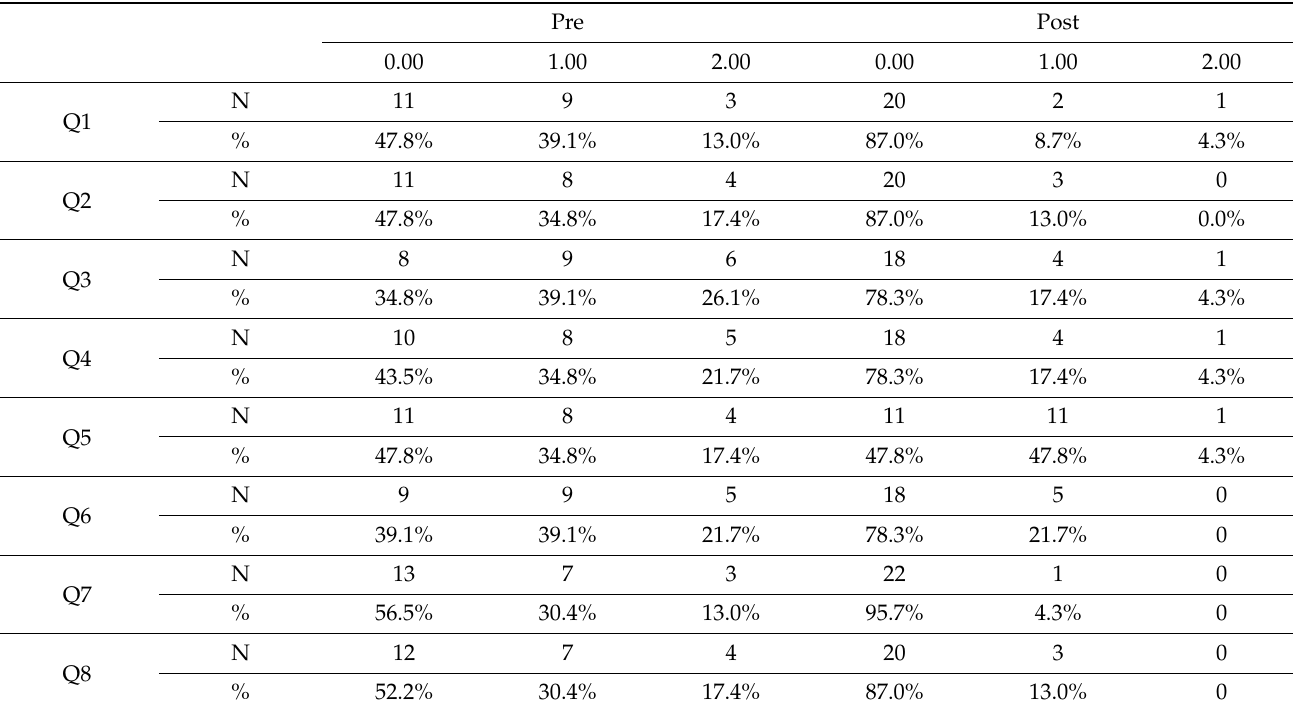
Table 4. Pre and post DDQ8